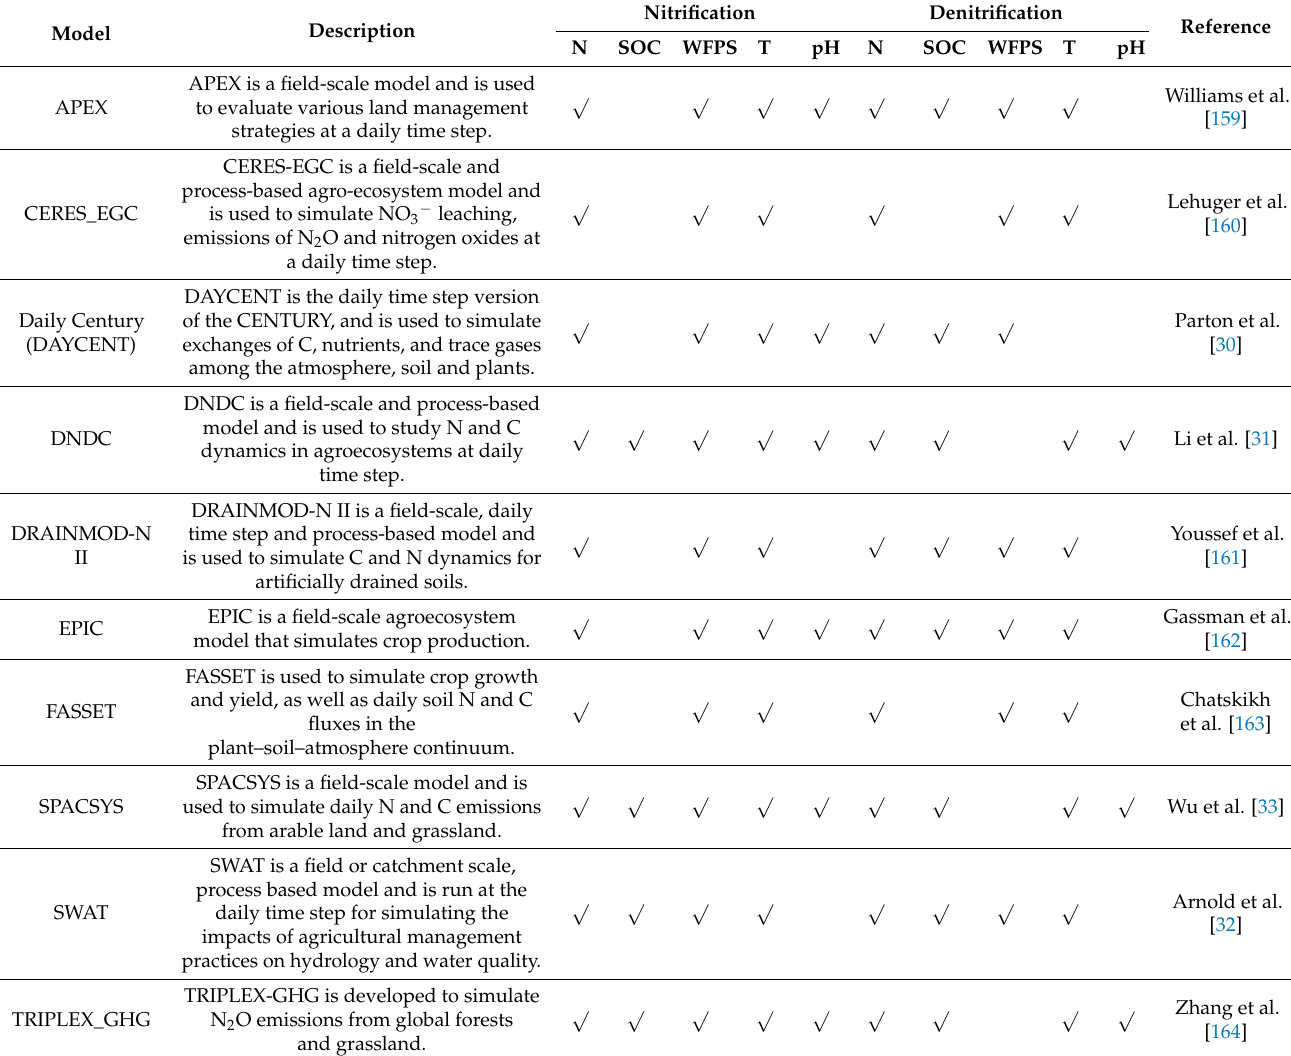
Table 4. Dynamic models used to simulate nitrification and denitrification in agricultural fields and the impact factors considered. Model